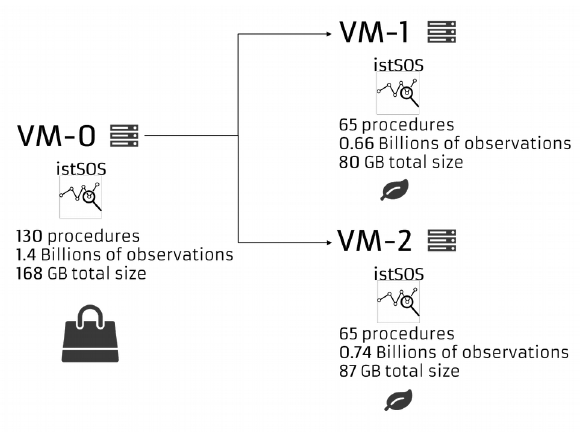
Figure 4. Schema of the VMs built to run the load test.